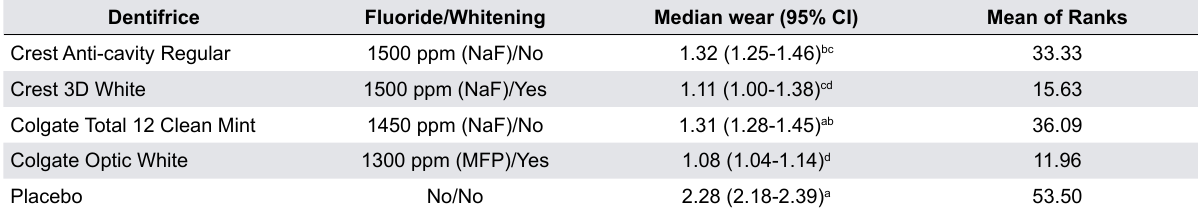
Table 1- Median wear of enamel (µm) after treatment with dentifrices containing whitening components or